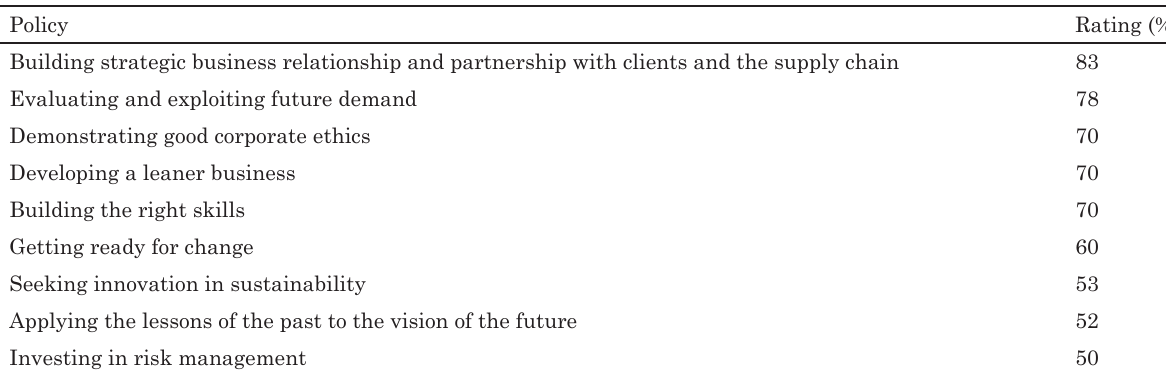
Table 6. Policies to immunise against the effects of the business